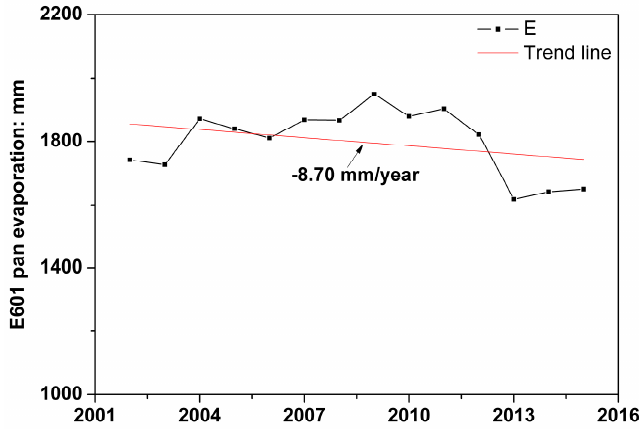
Figure 10. Observed annual E601 pan evaporation during 2002–2015.